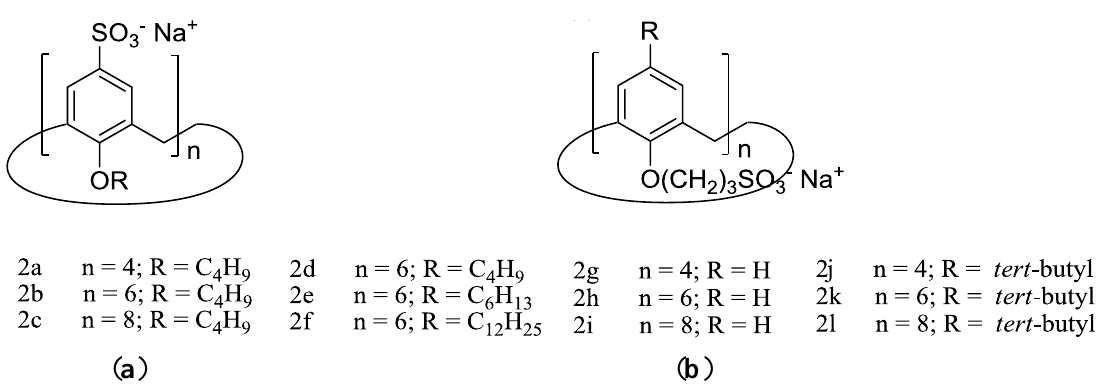
Figure 3. Amphiphilic sulfonatocalix[ n ]arenes bearing the hydrophilic SO 3− group at the ( a ) upper rim and ( b ) lower